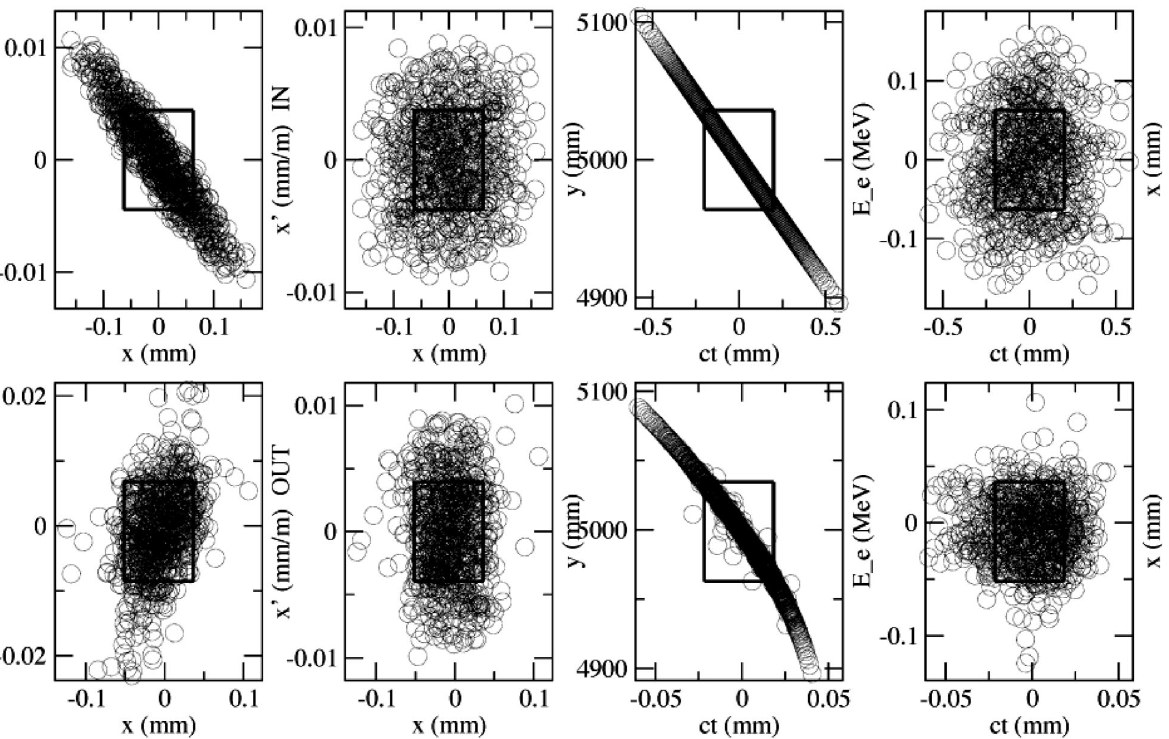
FIG. 15. Particle distributions at the entrance and exit from the ‘‘standard-chicane’’ benchmark [32]. However, to make the halo visible (in the bottom row, third plot over) the vertical emittance (cid:4) c has been reduced to 0.01 mm mr from its nominal value of 1 mm mr. Parameters for these graphs are q ¼ 1 nC , N p ¼ 800 , E e ¼ 5 : 0 GeV , l ; y ; ct ; (cid:3) Þ ¼ ð 63% ; 3 : 6% ; 200% ; 0 : 0002% Þ distributions (in microns) are ð x hw hw hw hw